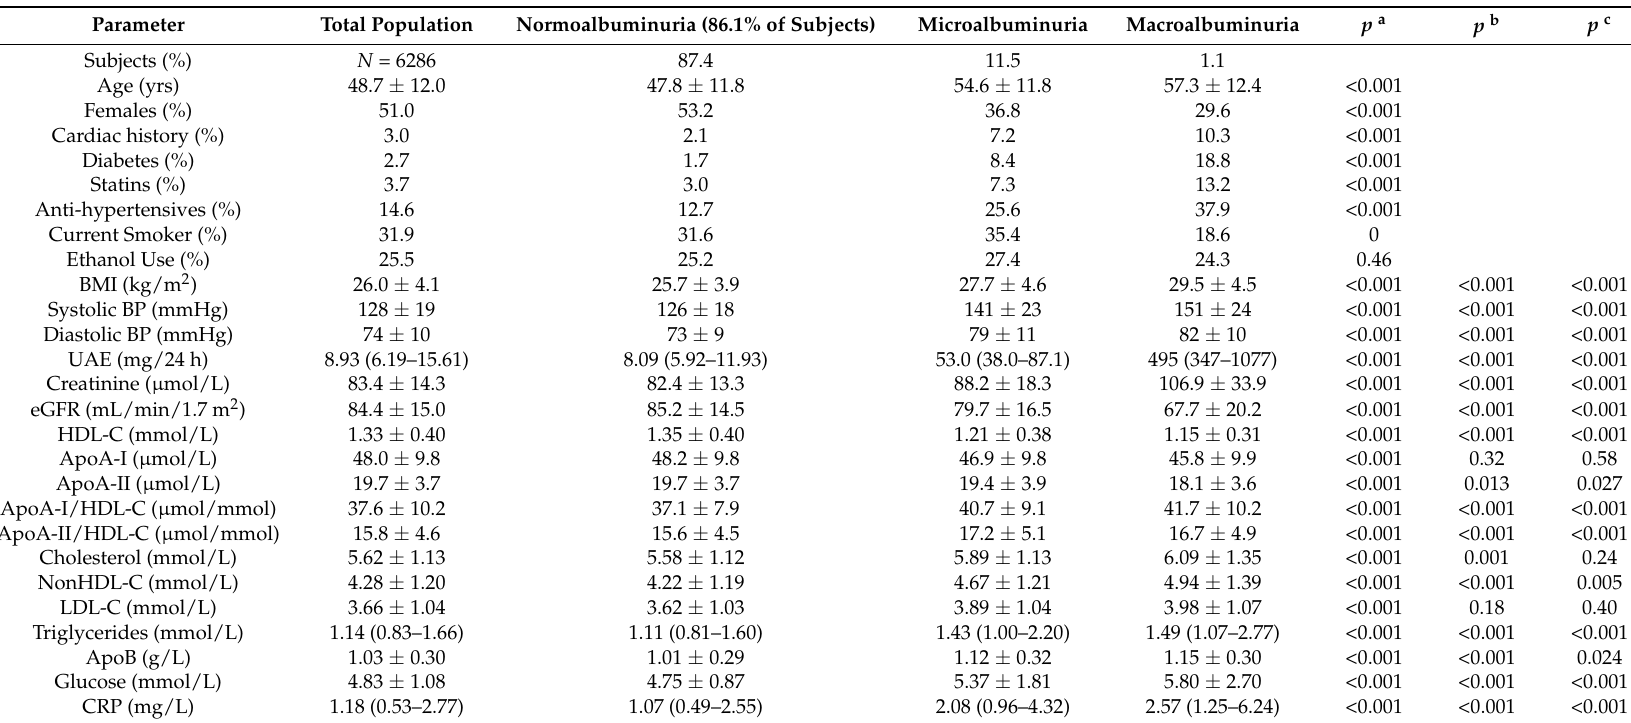
Table 1. Clinical covariates and biomarker levels (mean ± SD or median (interquartile range)) of the study population at the baseline evaluation stratified according